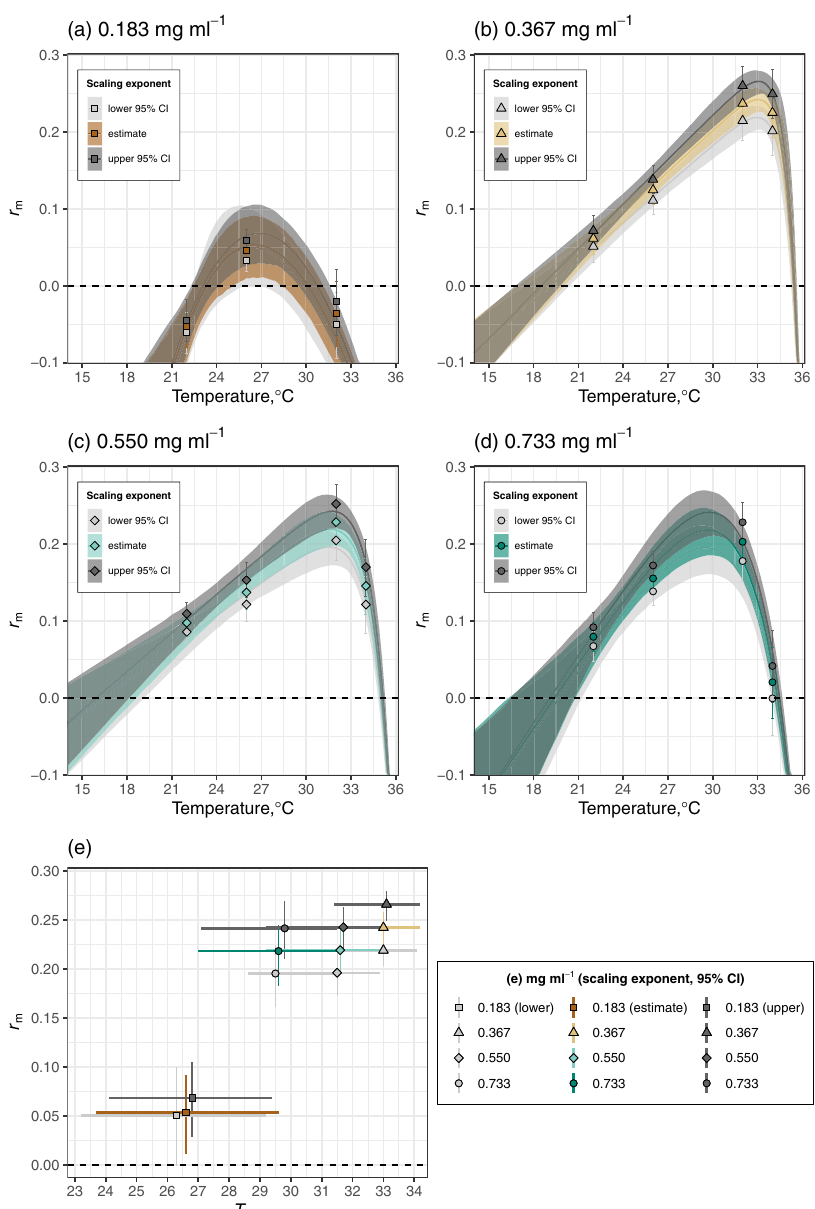
Fig. 4 The insensitivity of the population fi tness ( r m ) TPCs to uncertainty in our fecundity estimates by resource level. a – d Comparison with the central estimates (coloured lines and 95% con fi dence bounds compared with greyscale lines and CBs) shows that, for all resource levels, using the upper and lower 95% exponents (Supplementary Eq. 1, Supplementary Fig. 1b) for the scaling between lifetime fecundity and size does not qualitatively change the predicted r m TPCs, or the matrix projection r m estimates (represented by symbols) that were used to fi t the r m TPCs. e The insensitivity of predicted r m T opt to uncertainty in our fecundity estimates by resource level. Using the upper and lower 95% exponents (Supplementary Eq. 1, Supplementary Fig. 1b) for the scaling between lifetime fecundity and size does not qualitatively change predicted maximal r m (symbols with 95% CIs (vertical, coloured lines)) or r m T opt (symbols with 95% CIs (horizontal coloured lines)). Source data for the central estimates can be found in Supplementary Data 2; the other source data are in Supplementary Data